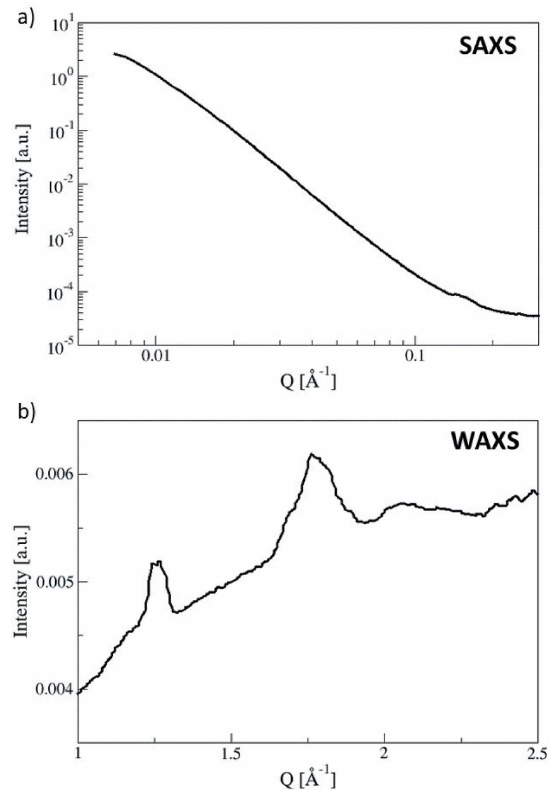
Figure 2 Empty cell scattering spectra: ( a ) SAXS and ( b ) WAXS